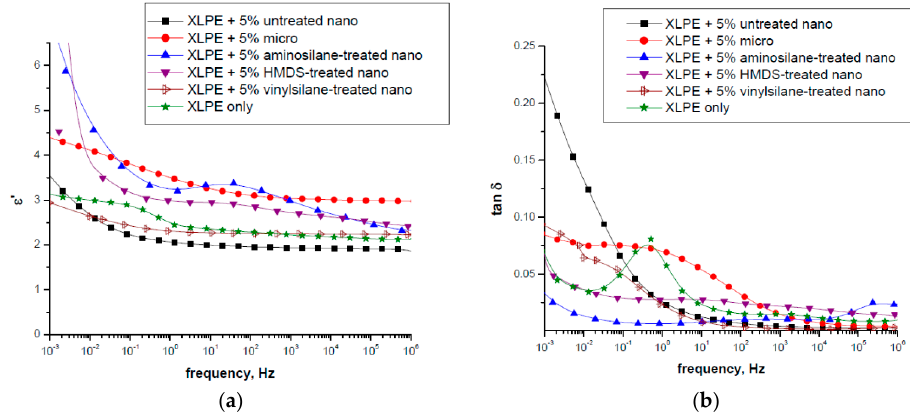
Figure 25. ( a ) Real part of relative permittivity and ( b ) loss tangent of functionalized XLPE at 23 °C (© 2016 IEEE. Reprinted, with permission, from [102]).